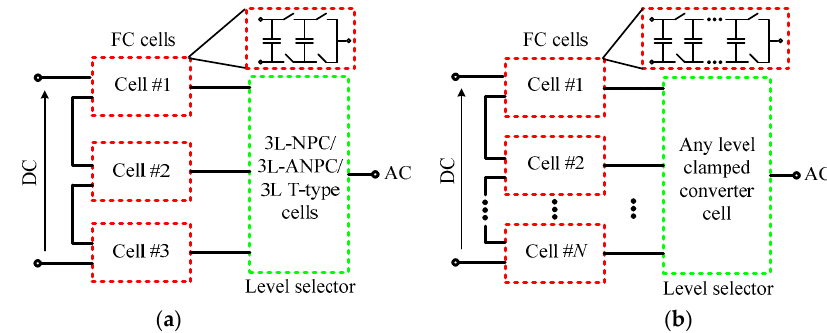
Figure 10. General topologies of hybrid cascaded multilevel converters by cascading ( a ) three 3L FC cells, ( b ) N ‐ cell multilevel FC cells.